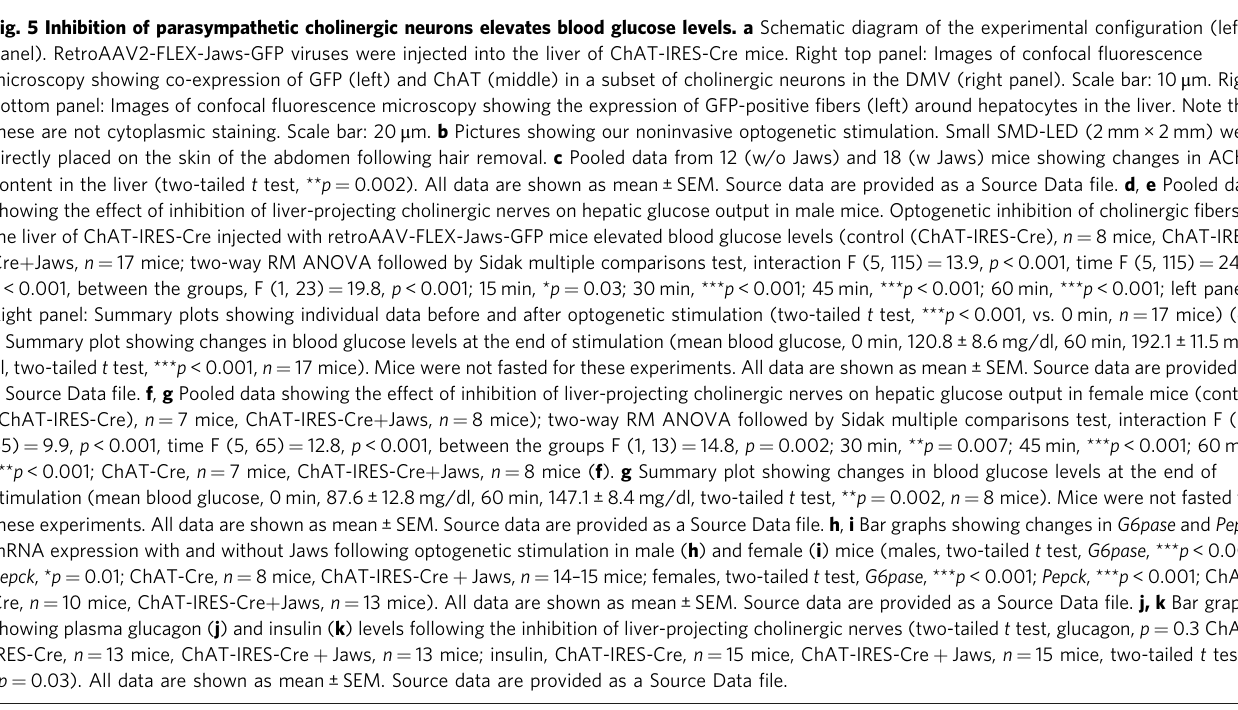
Fig. 5 Inhibition of parasympathetic cholinergic neurons elevates blood glucose levels. a Schematic diagram of the experimental con fi guration (left panel). RetroAAV2-FLEX-Jaws-GFP viruses were injected into the liver of ChAT-IRES-Cre mice. Right top panel: Images of confocal fl uorescence microscopy showing co-expression of GFP (left) and ChAT (middle) in a subset of cholinergic neurons in the DMV (right panel). Scale bar: 10 μ m. Right bottom panel: Images of confocal fl uorescence microscopy showing the expression of GFP-positive fi bers (left) around hepatocytes in the liver. Note that these are not cytoplasmic staining. Scale bar: 20 μ m. b Pictures showing our noninvasive optogenetic stimulation. Small SMD-LED (2 mm × 2 mm) were directly placed on the skin of the abdomen following hair removal. c Pooled data from 12 (w/o Jaws) and 18 (w Jaws) mice showing changes in ACh content in the liver (two-tailed t test, ** p = 0.002). All data are shown as mean ± SEM. Source data are provided as a Source Data fi le. d , e Pooled data showing the effect of inhibition of liver-projecting cholinergic nerves on hepatic glucose output in male mice. Optogenetic inhibition of cholinergic fi bers in the liver of ChAT-IRES-Cre injected with retroAAV-FLEX-Jaws-GFP mice elevated blood glucose levels (control (ChAT-IRES-Cre), n = 8 mice, ChAT-IRES- Cre + Jaws, n = 17 mice; two-way RM ANOVA followed by Sidak multiple comparisons test, interaction F (5, 115) = 13.9, p < 0.001, time F (5, 115) = 24.6, p < 0.001, between the groups, F (1, 23) = 19.8, p < 0.001; 15 min, * p = 0.03; 30 min, *** p < 0.001; 45 min, *** p < 0.001; 60 min, *** p < 0.001; left panel). Right panel: Summary plots showing individual data before and after optogenetic stimulation (two-tailed t test, *** p < 0.001, vs. 0 min, n = 17 mice) ( d ). e Summary plot showing changes in blood glucose levels at the end of stimulation (mean blood glucose, 0 min, 120.8 ± 8.6 mg/dl, 60 min, 192.1 ± 11.5 mg/ dl, two-tailed t test, *** p < 0.001, n = 17 mice). Mice were not fasted for these experiments. All data are shown as mean ± SEM. Source data are provided as a Source Data fi le. f , g Pooled data showing the effect of inhibition of liver-projecting cholinergic nerves on hepatic glucose output in female mice (control (ChAT-IRES-Cre), n = 7 mice, ChAT-IRES-Cre + Jaws, n = 8 mice); two-way RM ANOVA followed by Sidak multiple comparisons test, interaction F (5, 65) = 9.9, p < 0.001, time F (5, 65) = 12.8, p < 0.001, between the groups F (1, 13) = 14.8, p = 0.002; 30 min, ** p = 0.007; 45 min, *** p < 0.001; 60 min, *** p < 0.001; ChAT-Cre, n = 7 mice, ChAT-IRES-Cre + Jaws, n = 8 mice ( f ). g Summary plot showing changes in blood glucose levels at the end of stimulation (mean blood glucose, 0 min, 87.6 ± 12.8 mg/dl, 60 min, 147.1 ± 8.4 mg/dl, two-tailed t test, ** p = 0.002, n = 8 mice). Mice were not fasted for these experiments. All data are shown as mean ± SEM. Source data are provided as a Source Data fi le. h , i Bar graphs showing changes in G6pase and Pepck mRNA expression with and without Jaws following optogenetic stimulation in male ( h ) and female ( i ) mice (males, two-tailed t test, G6pase , *** p < 0.001; Pepck , * p = 0.01; ChAT-Cre, n = 8 mice, ChAT-IRES-Cre + Jaws, n = 14 – 15 mice; females, two-tailed t test, G6pase , *** p < 0.001; Pepck , *** p < 0.001; ChAT- Cre, n = 10 mice, ChAT-IRES-Cre + Jaws, n = 13 mice). All data are shown as mean ± SEM. Source data are provided as a Source Data fi le. j, k Bar graphs showing plasma glucagon ( j ) and insulin ( k ) levels following the inhibition of liver-projecting cholinergic nerves (two-tailed t test, glucagon, p = 0.3 ChAT- IRES-Cre, n = 13 mice, ChAT-IRES-Cre + Jaws, n = 13 mice; insulin, ChAT-IRES-Cre, n = 15 mice, ChAT-IRES-Cre + Jaws, n = 15 mice, two-tailed t